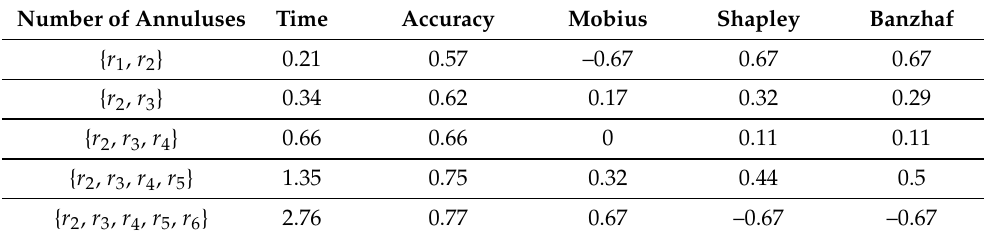
Table 7. Annuluses of DEPT in Mobius representation and mutual influence